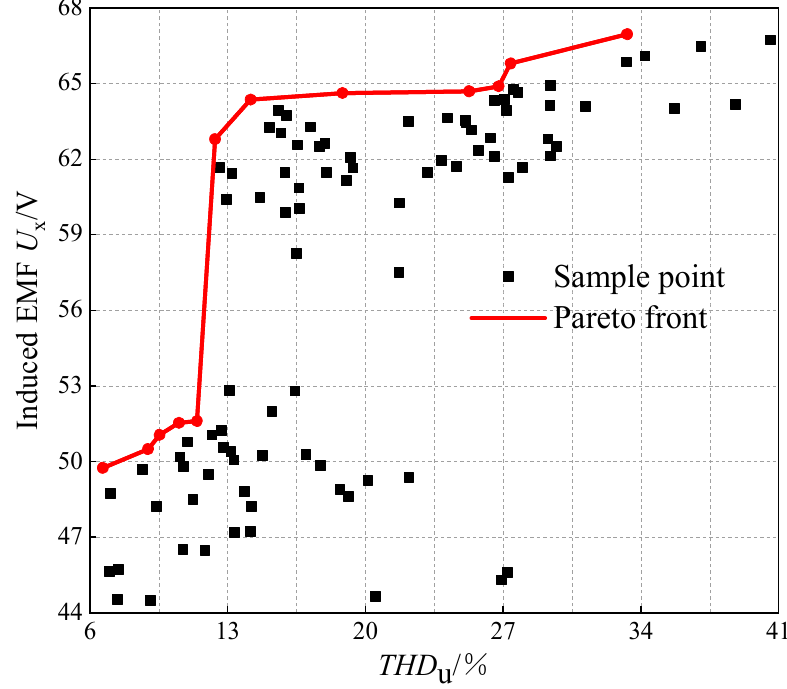
Figure 13. Pareto frontier distribution map.